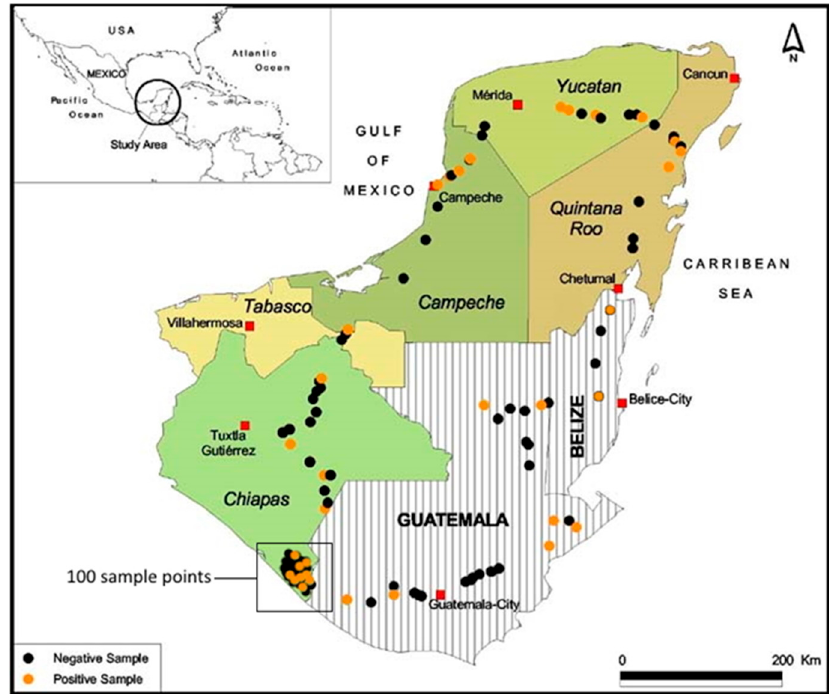
Figure 1. Distribution of soils samples that proved positive (orange points) or negative (black points) for SfMNPV OBs in the soil-diet bioassay. Samples were distributed across fives states of southern Mexico, Belize, and Guatemala. Intensive sampling was performed in the Soconusco region in the south of Chiapas State, Mexico (shown enclosed in a black rectangle). Table 1. Results of insect bioassays on soil samples according to Mexican State and